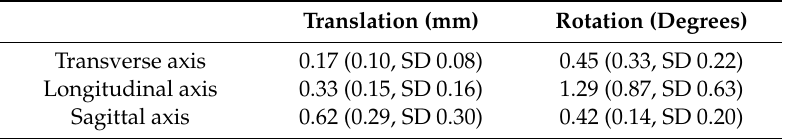
Table 2. The precision (with mean and SD) of radiostereometric analysis (RSA) measurements as investigated by double examinations in 28 patients at the 6-month follow-up.